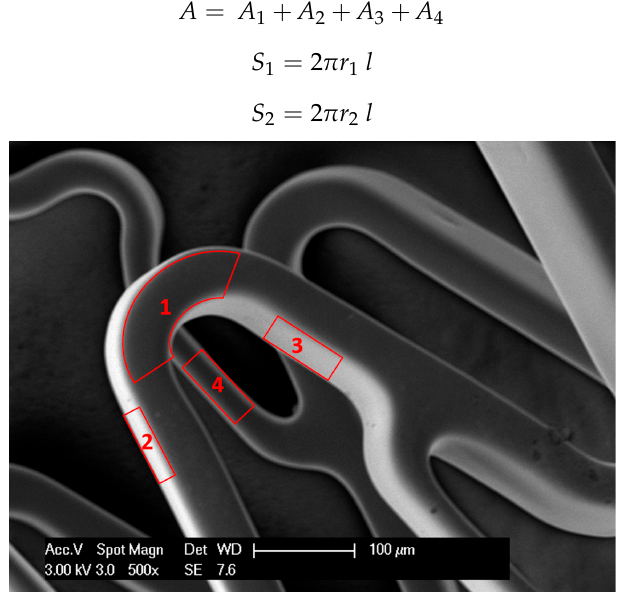
Figure 1. Scanning electron microscopy (SEM) image of a stent showing 4 surfaces of stent wire: upper or outer surface (1), bottom or inner surface (4), right and left surfaces (2,3).